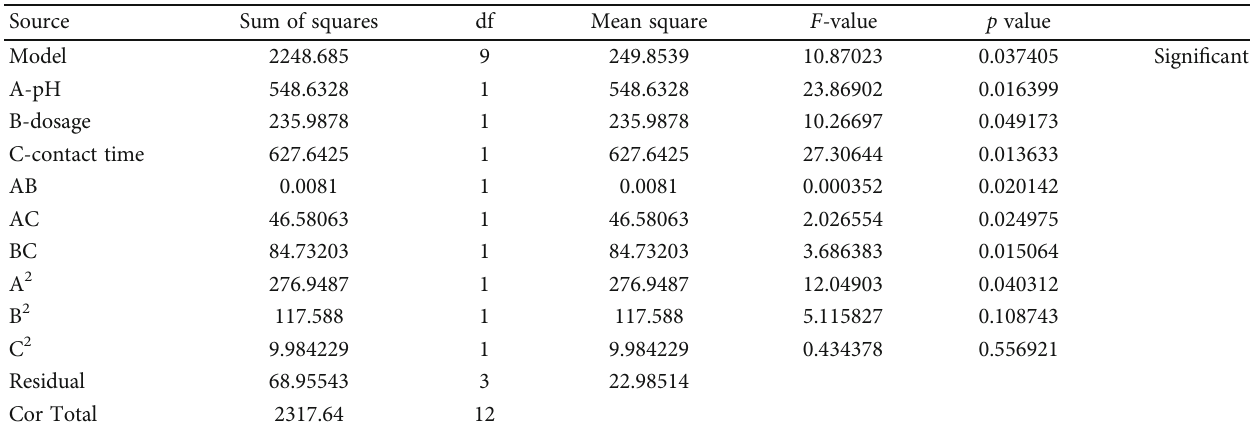
Table 6: ANOVA for removal e ffi ciencies using